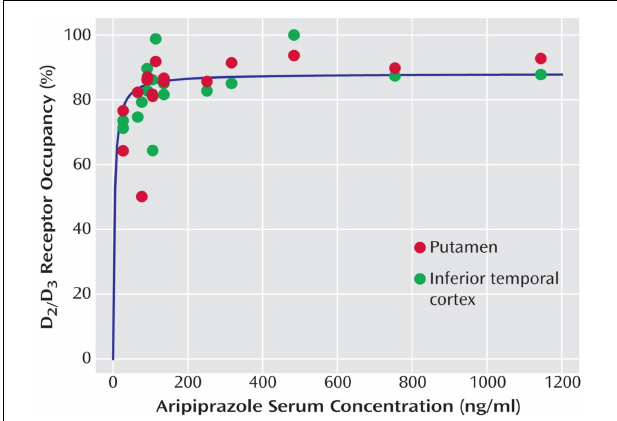
FIGURE 2 | Relationship between aripiprazole serum levels and dopamine D2/D3 receptor occupancy in the putamen and the inferior temporal cortex (representative of cortical binding due to high D2/D3 receptor density) in 16 patients with schizophrenia and schizoaffective disorder receiving therapeutic doses of aripiprazole. Copyright © American Psychiatric Association. From